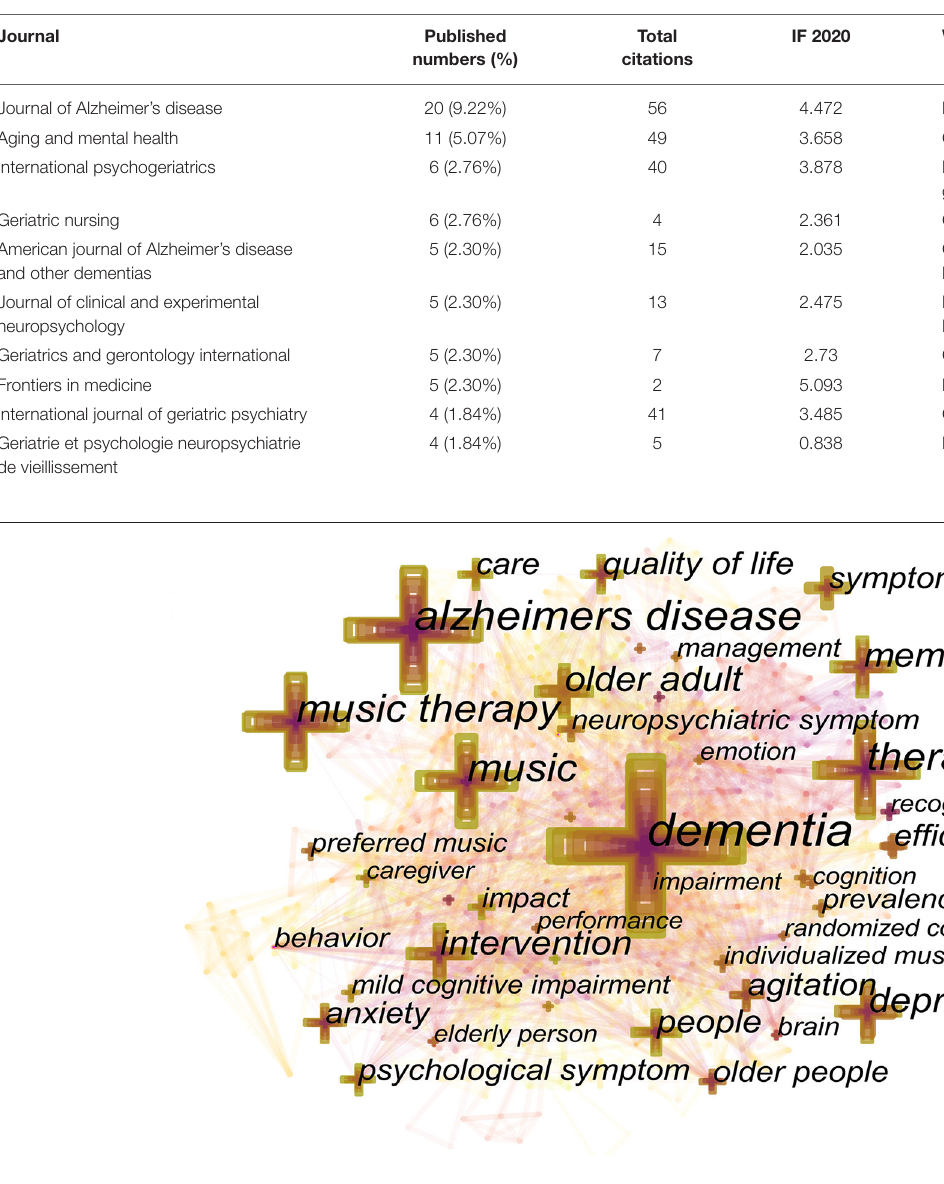
TABLE 2 | Summary of the top 10 journals.